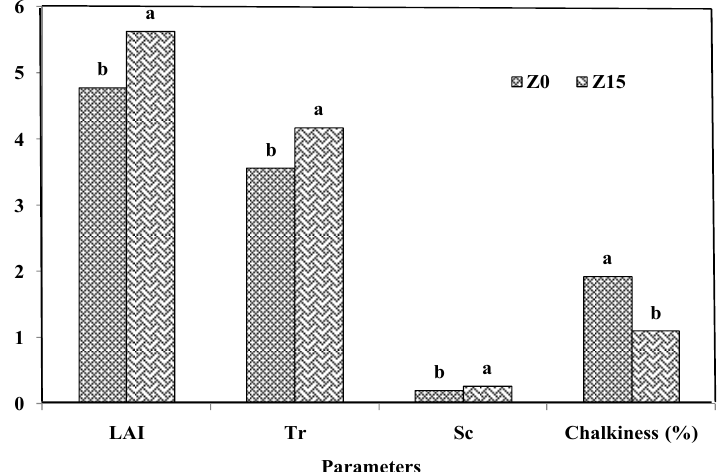
Figure 11. Effect of Zeolite Application on Tillering Pattern of Rice. Modified from Chen et al. [29].